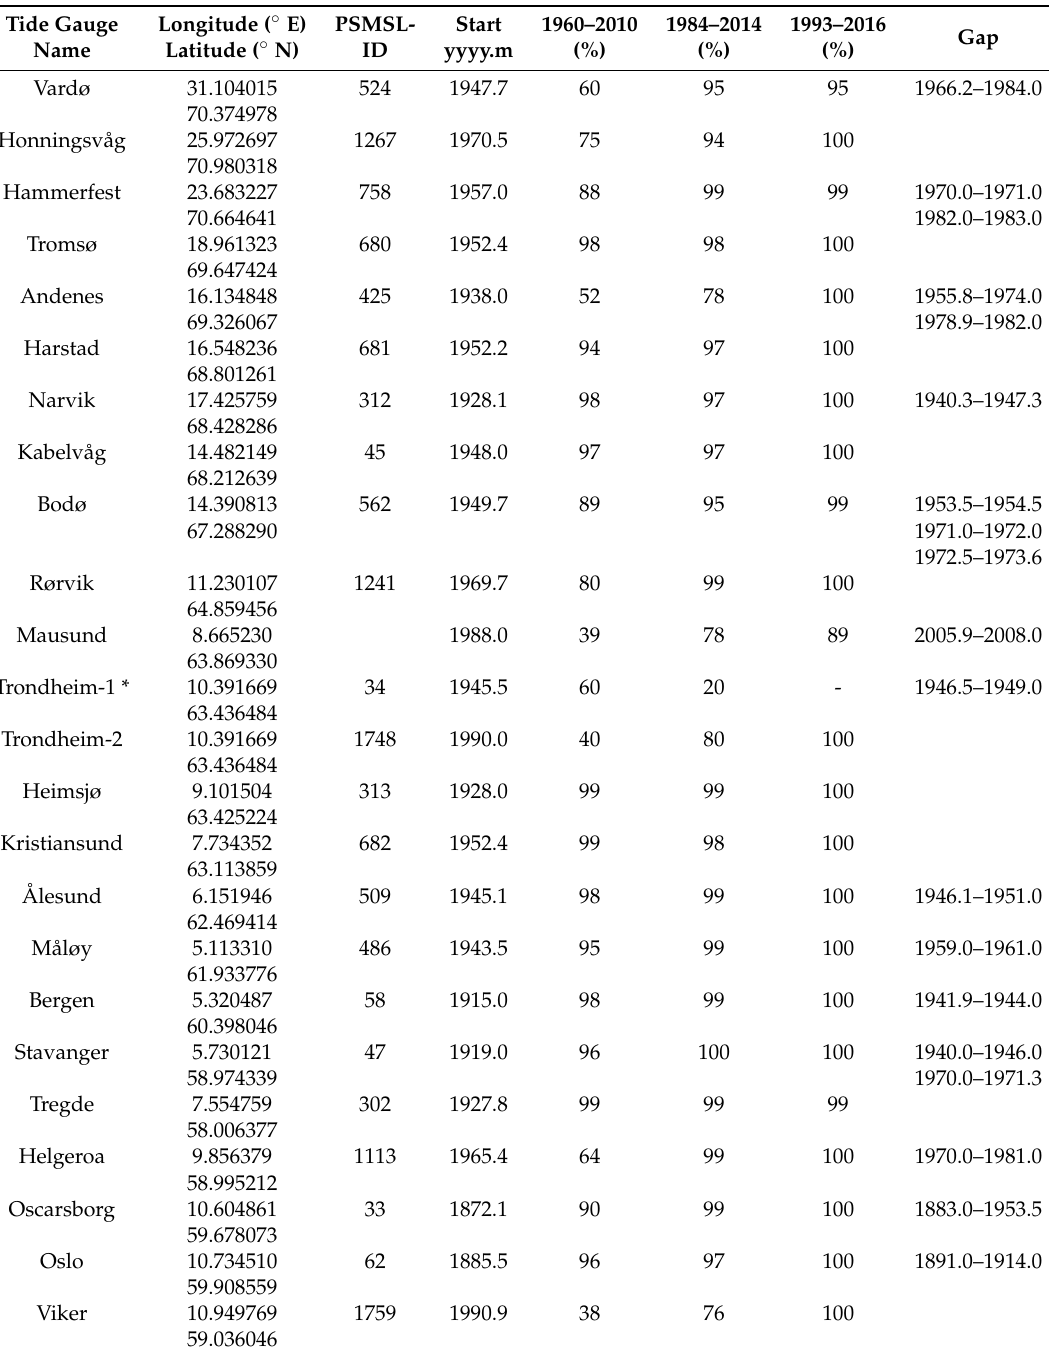
Table 1. Overview of the Norwegian tide gauges, ordered along the coast from north to south. The table lists longitude/latitude [degrees] of each tide gauge (from the archive of the Norwegian Mapping Authority), id-numbers in the Permanent Service for Mean Sea Level–archive, the start month of each record, the percentage of observations available for the periods 1960–2010, 1984–2014, and 1993–2016, and significant gaps (>= 1 year). (* : The tide gauge in Trondheim was relocated in